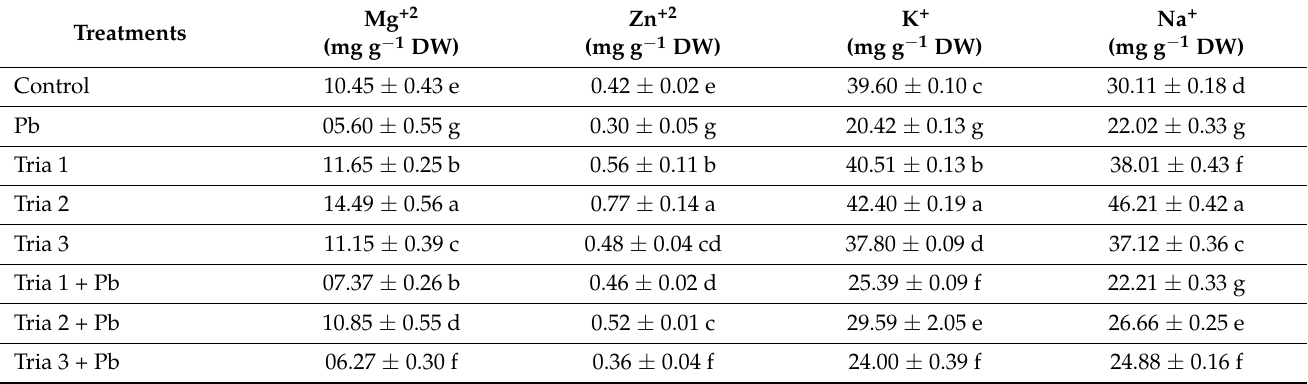
Table 5. Impact of Pb Triacontanol on the Uptake of Mineral Contents of Phaseolus vulgaris